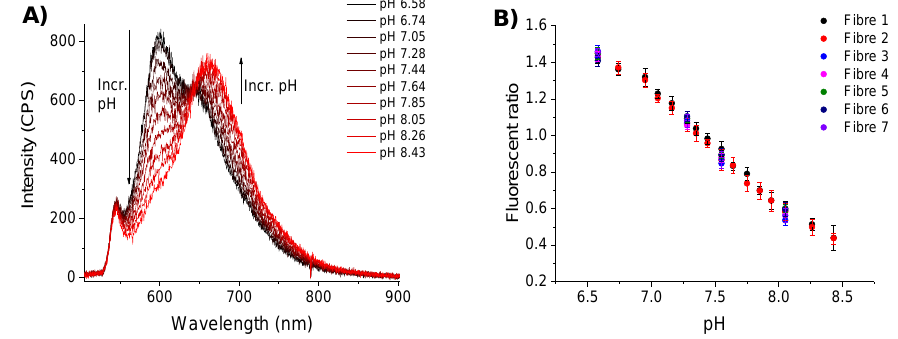
Figure 5. pH response of SNARF-2 embedded in polyacrylamide on fibre tip to varied pH. ( A ) Emission spectra of SNARF in various pH buffers; ( B ) Ratio of emission peak intensities 600/660nm shown with over multiple trials. The effect of noise was reduced by taking the mean of eight values between 598–602 nm and 558–662 nm. Error bars represent the standard deviation of these values.